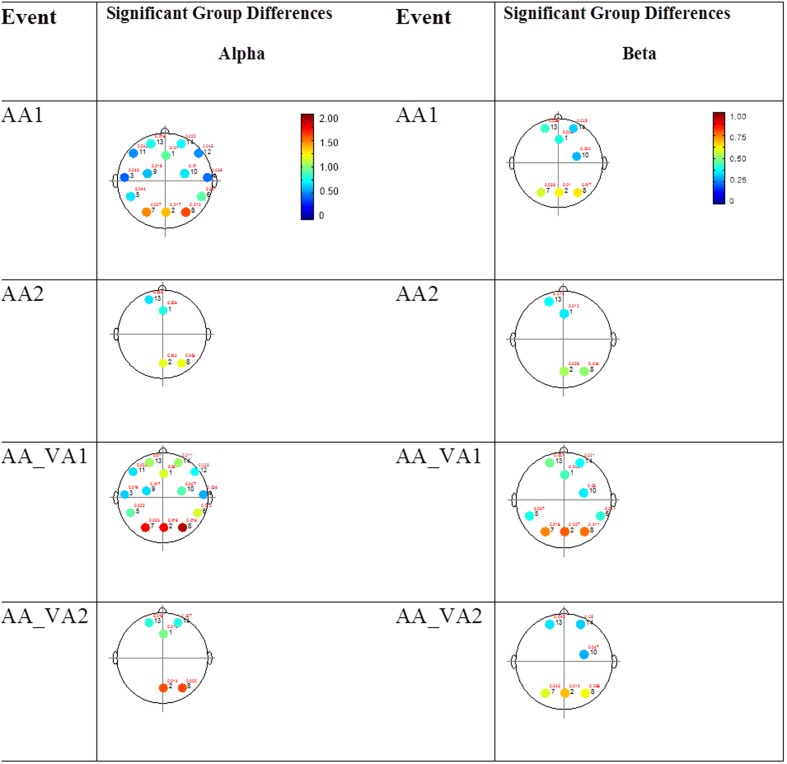
Session 2 alpha and beta EEG power group differences-unimodal auditory presentations. Results for the alpha band (left) and beta band (right) are presented. Significant differences were determined using the Tukey–Kramer method for p < 0.05.